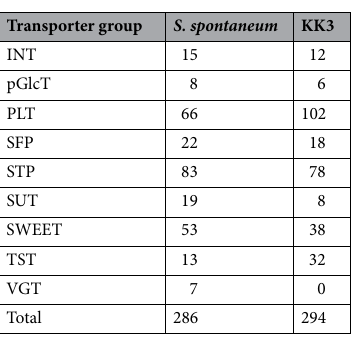
286 Table 2. Sugar transporter genes from S. spontaneum that were identified in KK3.